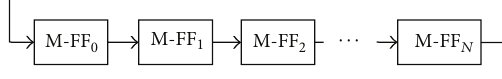
Figure 2: Ring counter